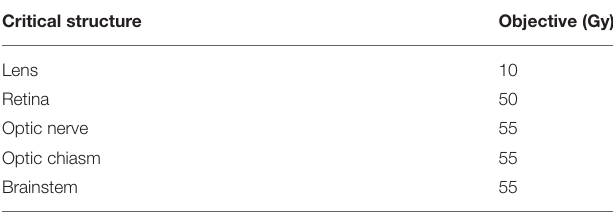
TABLE 1 | Critical structure radiation dose constraints. TABLE 2 | Baseline patient and tumor